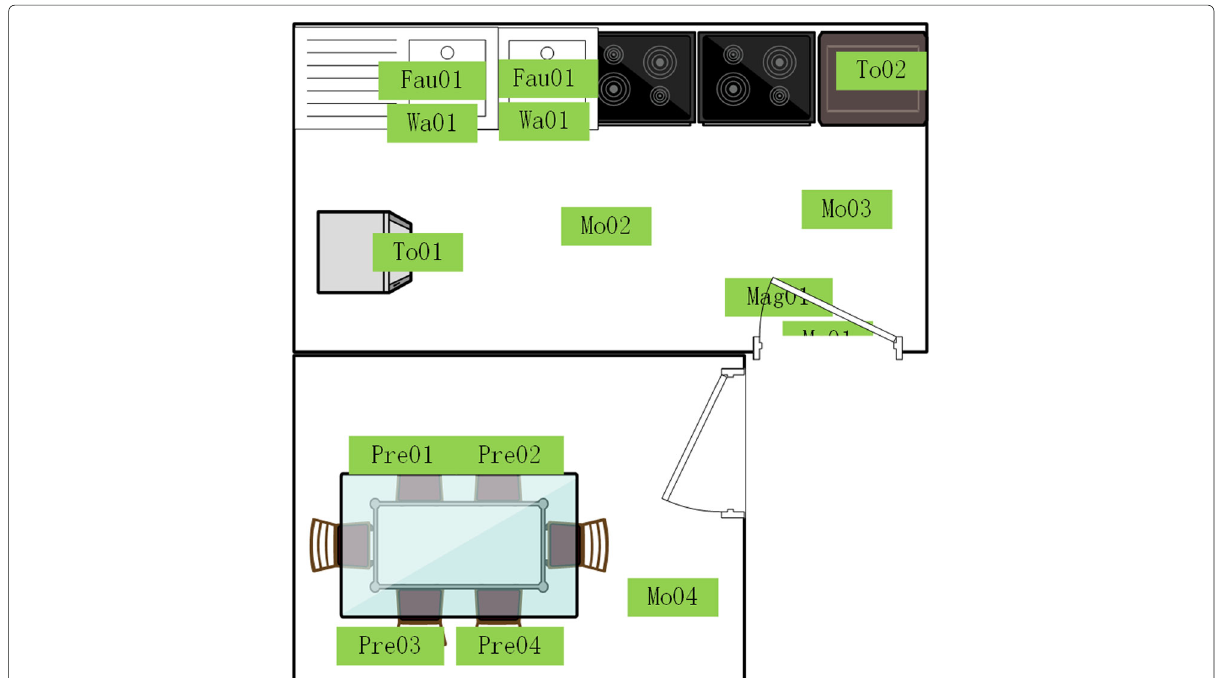
Fig. 1 A kitchen layout of multi-modeling